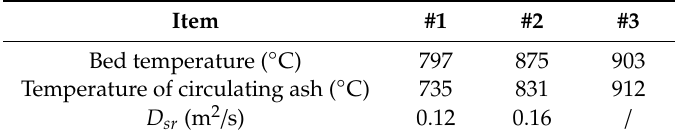
Figure 8. A schematic diagram of the 300 MW CFB boiler under the condition of local coal cut-off. Table 4. Temperature distributions and calculated lateral fuel dispersion coefficients under the coal cut-off condition.